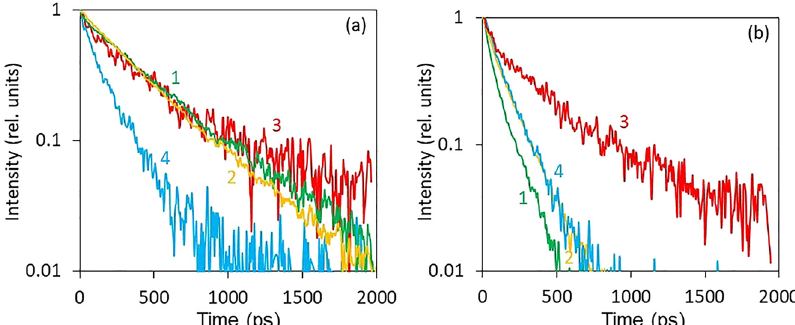
Figure 4: Emission kinetics (a) Emission kinetics of HITC:PMMA film at modest dye concentration n = 9.5 g/l deposited on glass (green trace 1), smooth Ag fi lms (yellow trace 2), and arrays of Ag nanowires: red trace 3 corresponds to the upper boundary of the emission kinetics spread, while blue trace 4 corresponds to its lower boundary. (b) Same for high dye concentration n = 24.6 g/l.